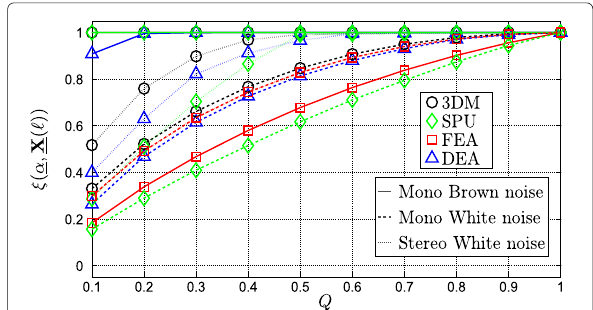
Fig. 9 Closeness Measure as a function of Q for mono brown, mono white, and stereo white noise signals for different tap selection